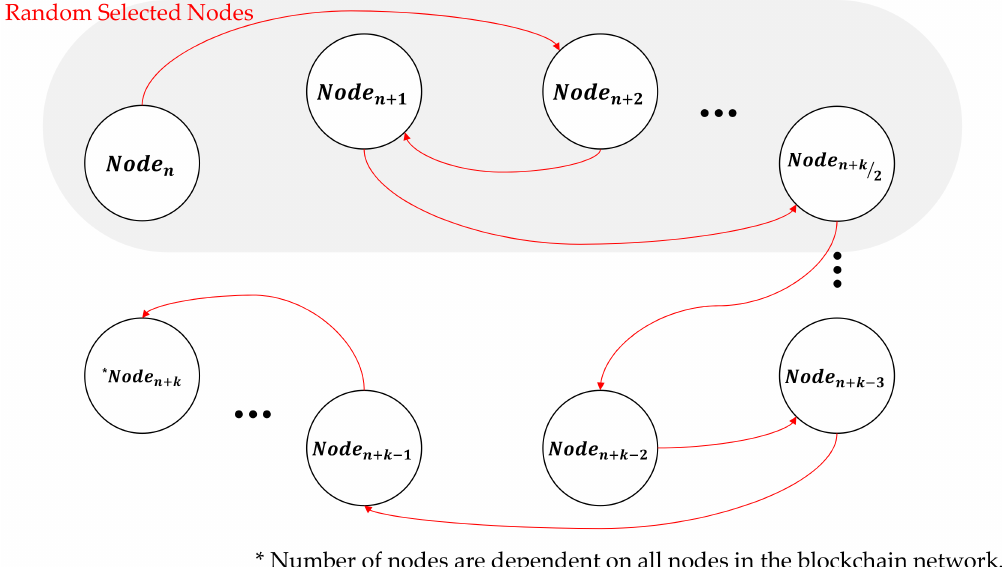
Figure 5. Proactive Approach for Eclipse Attacks.